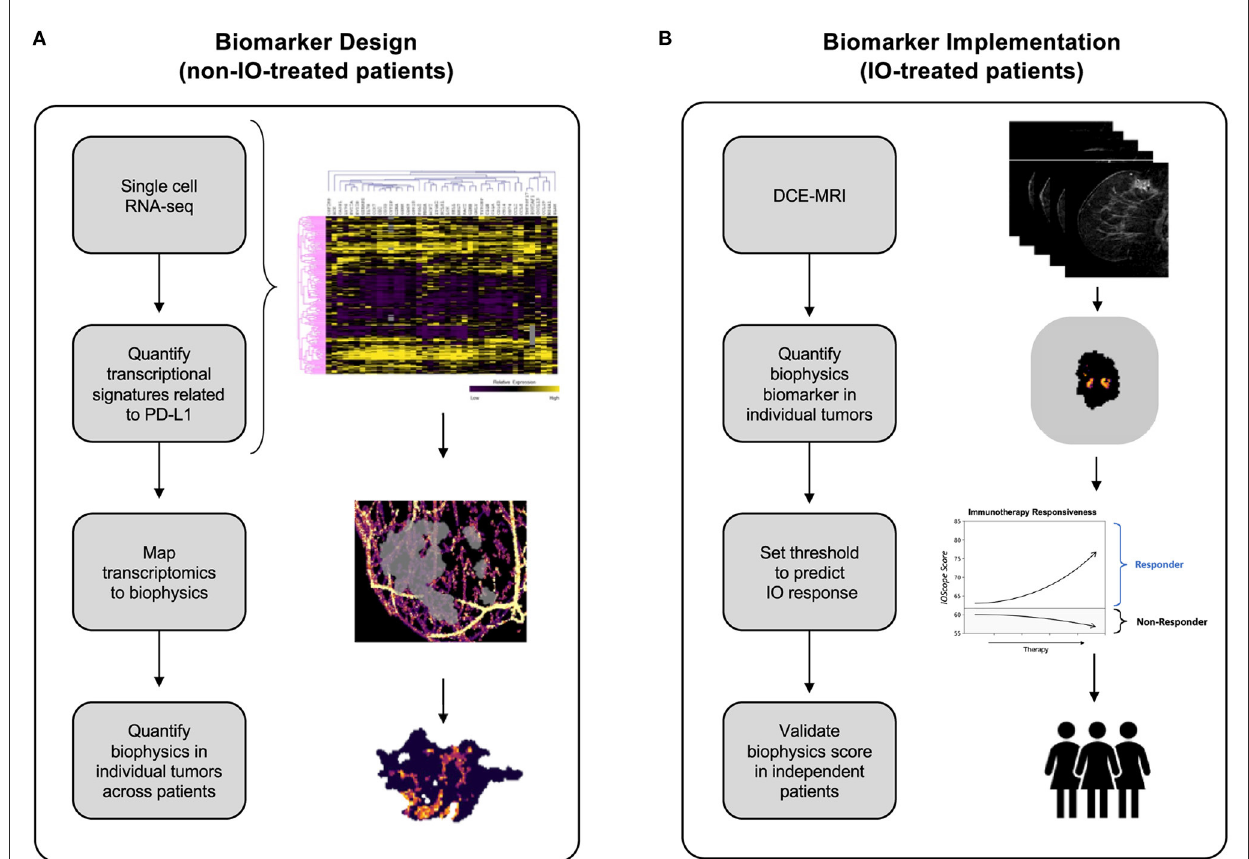
FIGURE1 Development of the TumorIO biomarker, as well as the design and implementation of the TumorIO Score predicting response to IO therapy. (A) The TumorIO biomarker was developed using non-IO-treated (and pre-IO-treated) patients from the I-SPY1 and I-SPY2 clinical trials, as well as single cell RNA-sequencing data. Transcriptomic gene expression signatures of cancer hallmarks were used to quantify metabolic activity and angiogenesis within single cells. These signatures were then correlated with PD-L1 expression to quantify the relationship between PD-L1 expression and tumor metabolic activity and angiogenesis. Subsequently, metabolic activity and angiogenesis were quantified within patient tumors based on biophysical modeling of DCE-MRI image series to generate spatially resolved probability maps of PD-L1 expression within individual patient tumors. (B) The TumorIO biomarker was implemented using IO-treated patients from the I-SPY2 clinical trial to develop the TumorIO Score associated with likelihood of pCR in response to IO therapy. The TumorIO Score was then validated in an independent set of patients and through a virtual clinical